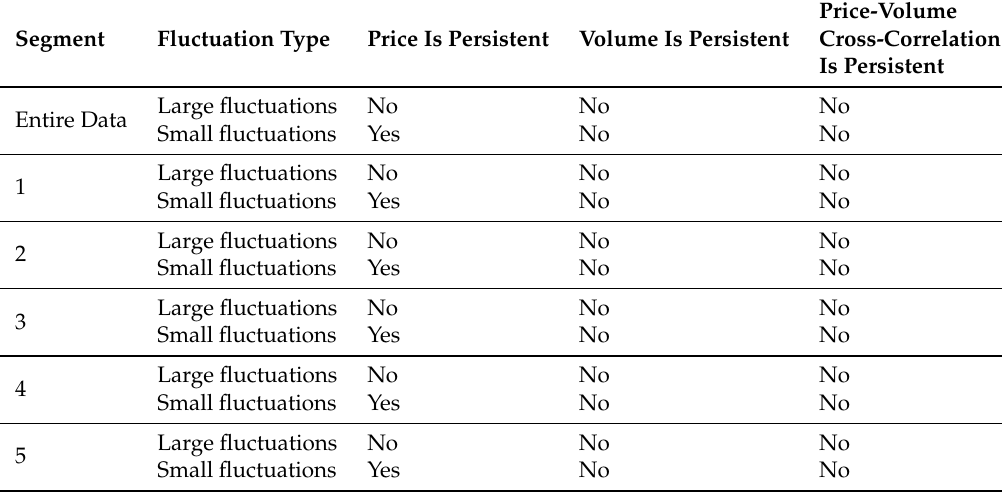
Table 3. Segment-wise comparison of results.